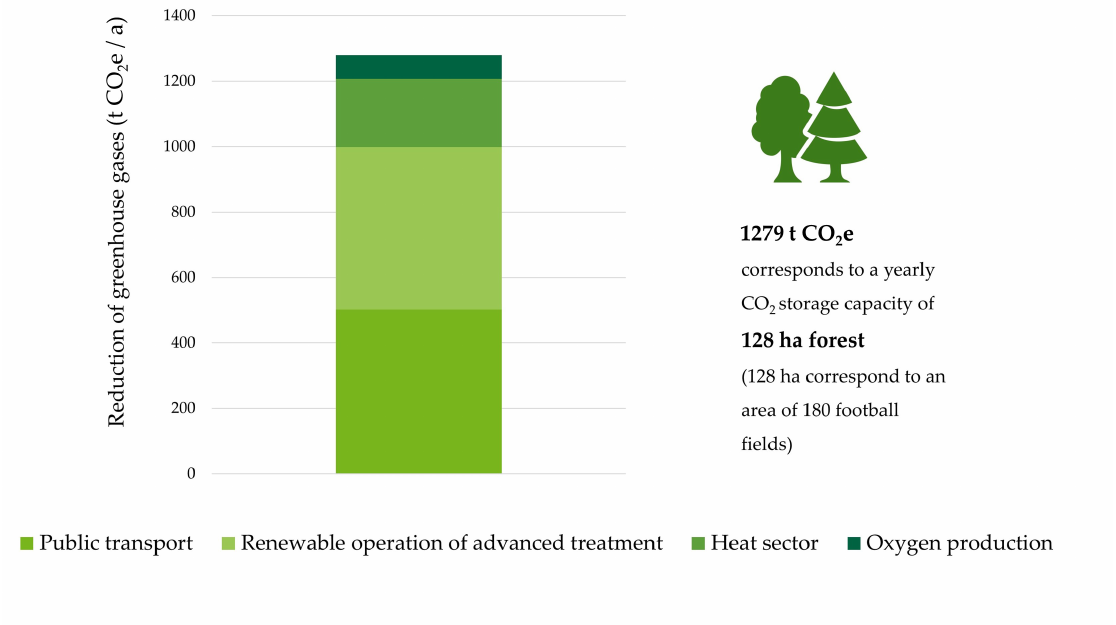
Figure 7. Annual savings in greenhouse gas emissions through the use of electrolysis after implementation of the project in comparison to conventional power use